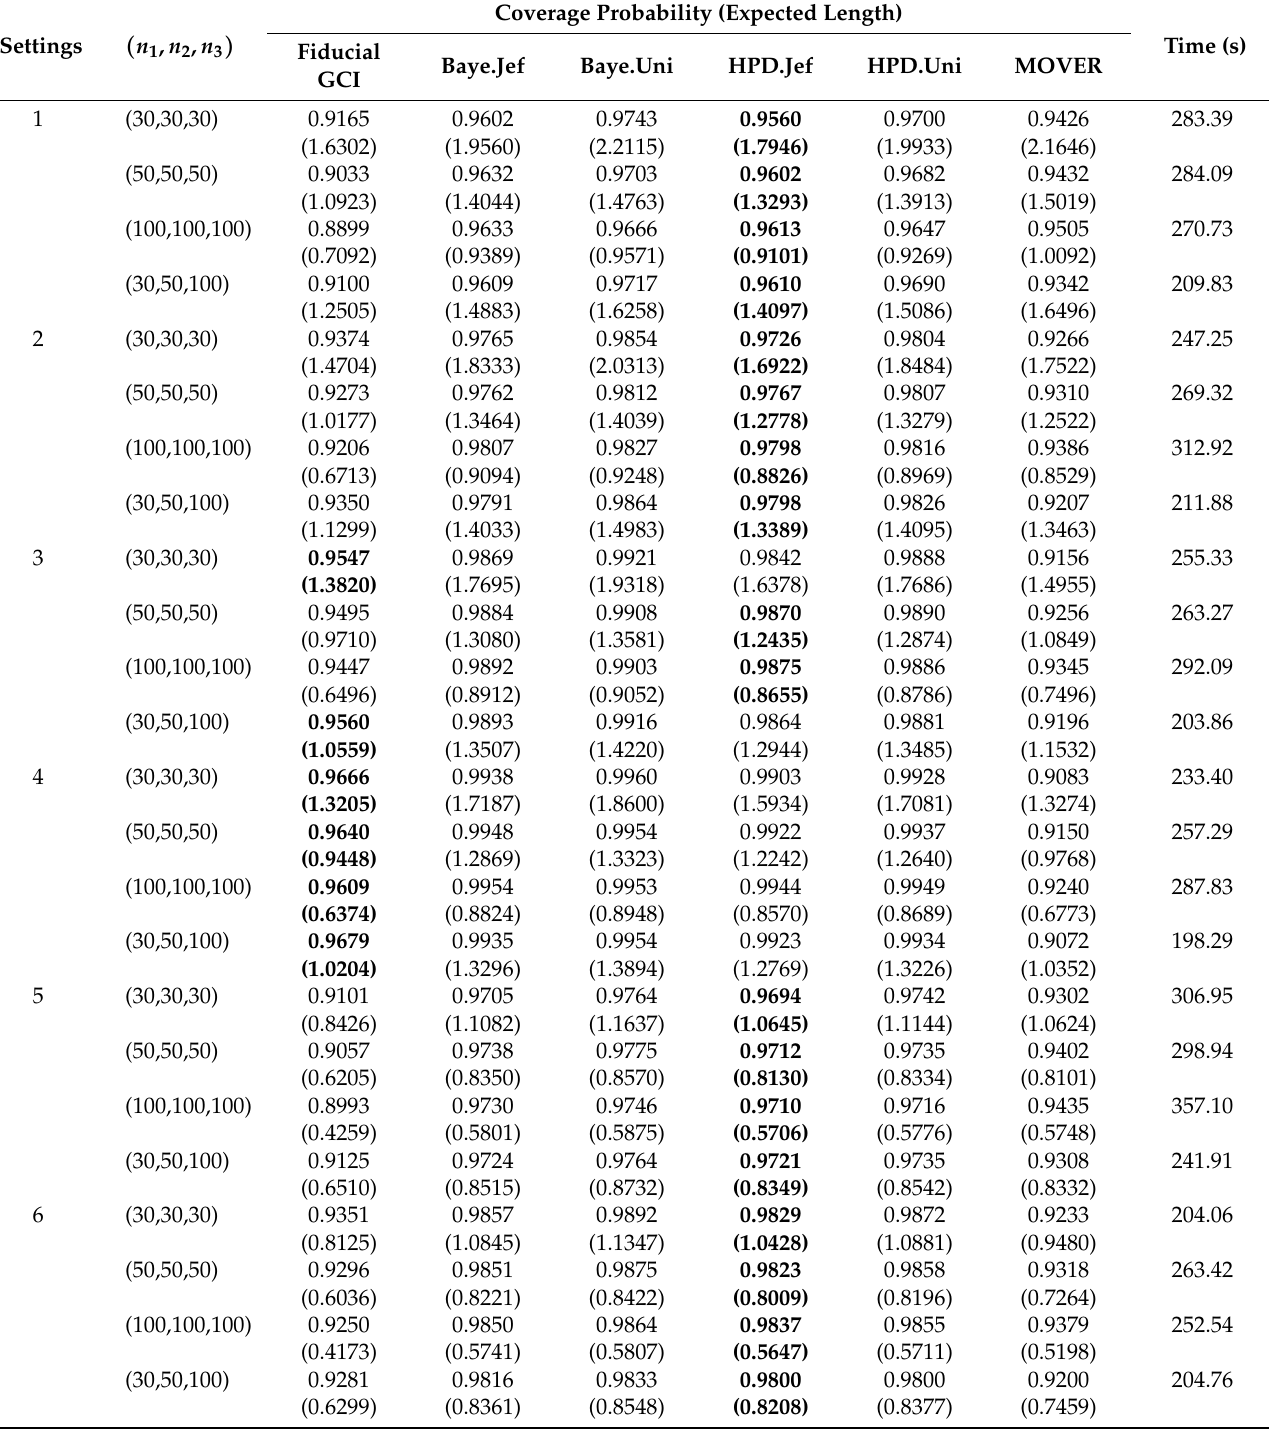
Table 3. Coverage probabilities and expected lengths for the 95% simultaneous CIs with λ il ( k = 3 )